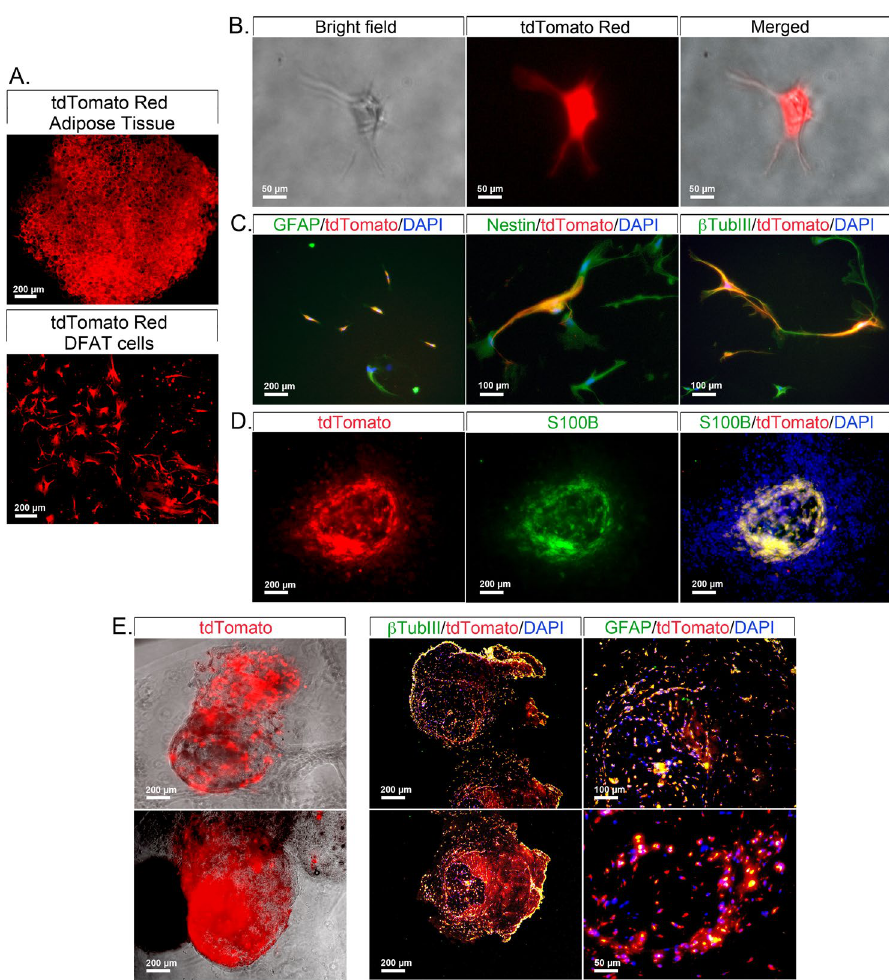
Figure 4. Mouse DFAT cells derived from combined BAT and WAT from Adipoq-cre/ERT;tdTomato mice after Tamoxifen induction. ( A ) TdTomato subcutaneous adipose tissue and mixed DFAT cells from Adipoq - cre/ERT2; tdTomato mice. ( B ) Bright field images of tdTomato DFAT cells after 15 days of culture in neural induction medium. ( C ) Co-localization of tdTomato (red) and the neurogenic markers glial fibrillary acidic protein (GFAP, green), Nestin (green), and β tubulin III (βTubIII, green) in DFAT cells after 15 days of culture in neural induction medium as visualized by immunofluorescence. ( D ) Co-localization of tdTomato and S100 Calcium Binding Protein B (S100β, green) in aggregates of tdTomato-positive DFAT cells as visualized by immunofluorescence. ( E ) Staining for βTubIII and GFAP in sections from DFAT cell clusters formed in 3D-Matrigel. DAPI (blue) was used to visualize nuclei. Representative images from 3–5